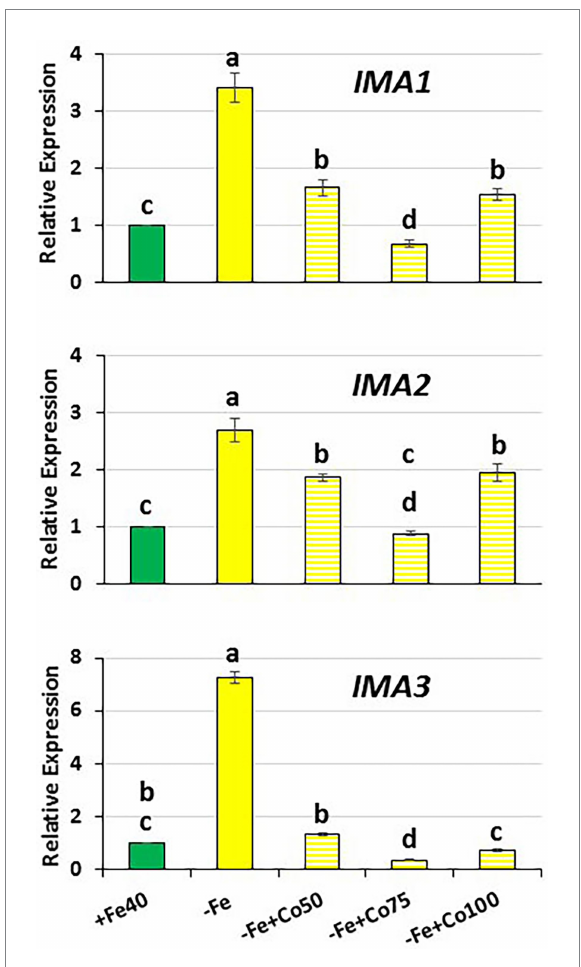
FIGURE 5 Effect of Fe deficiency and cobalt on IMA1 , IMA2 and IMA3 expression in roots of Arabidopsis WT Columbia. Plants were grown in complete nutrient solution. When appropriate, some of them were transferred during 48 h to complete nutrient solution with 40 μ M Fe-EDDHA (+Fe40) or without Fe (–Fe). Co, at different final concentrations (50, 75 or 100 μ M), was added to the nutrient solution without Fe during the last 24 h. IMA1 , IMA2 and IMA3 expression was determined by qRT-PCR. Relative expression was calculated in relation to the +Fe40 treatment. Data represent the mean of 3 independent biological replicates ± S.E. Bars with different letters indicate significant differences ( p < 0.05) using one-way analysis of variance (ANOVA) followed by a Tukey’s